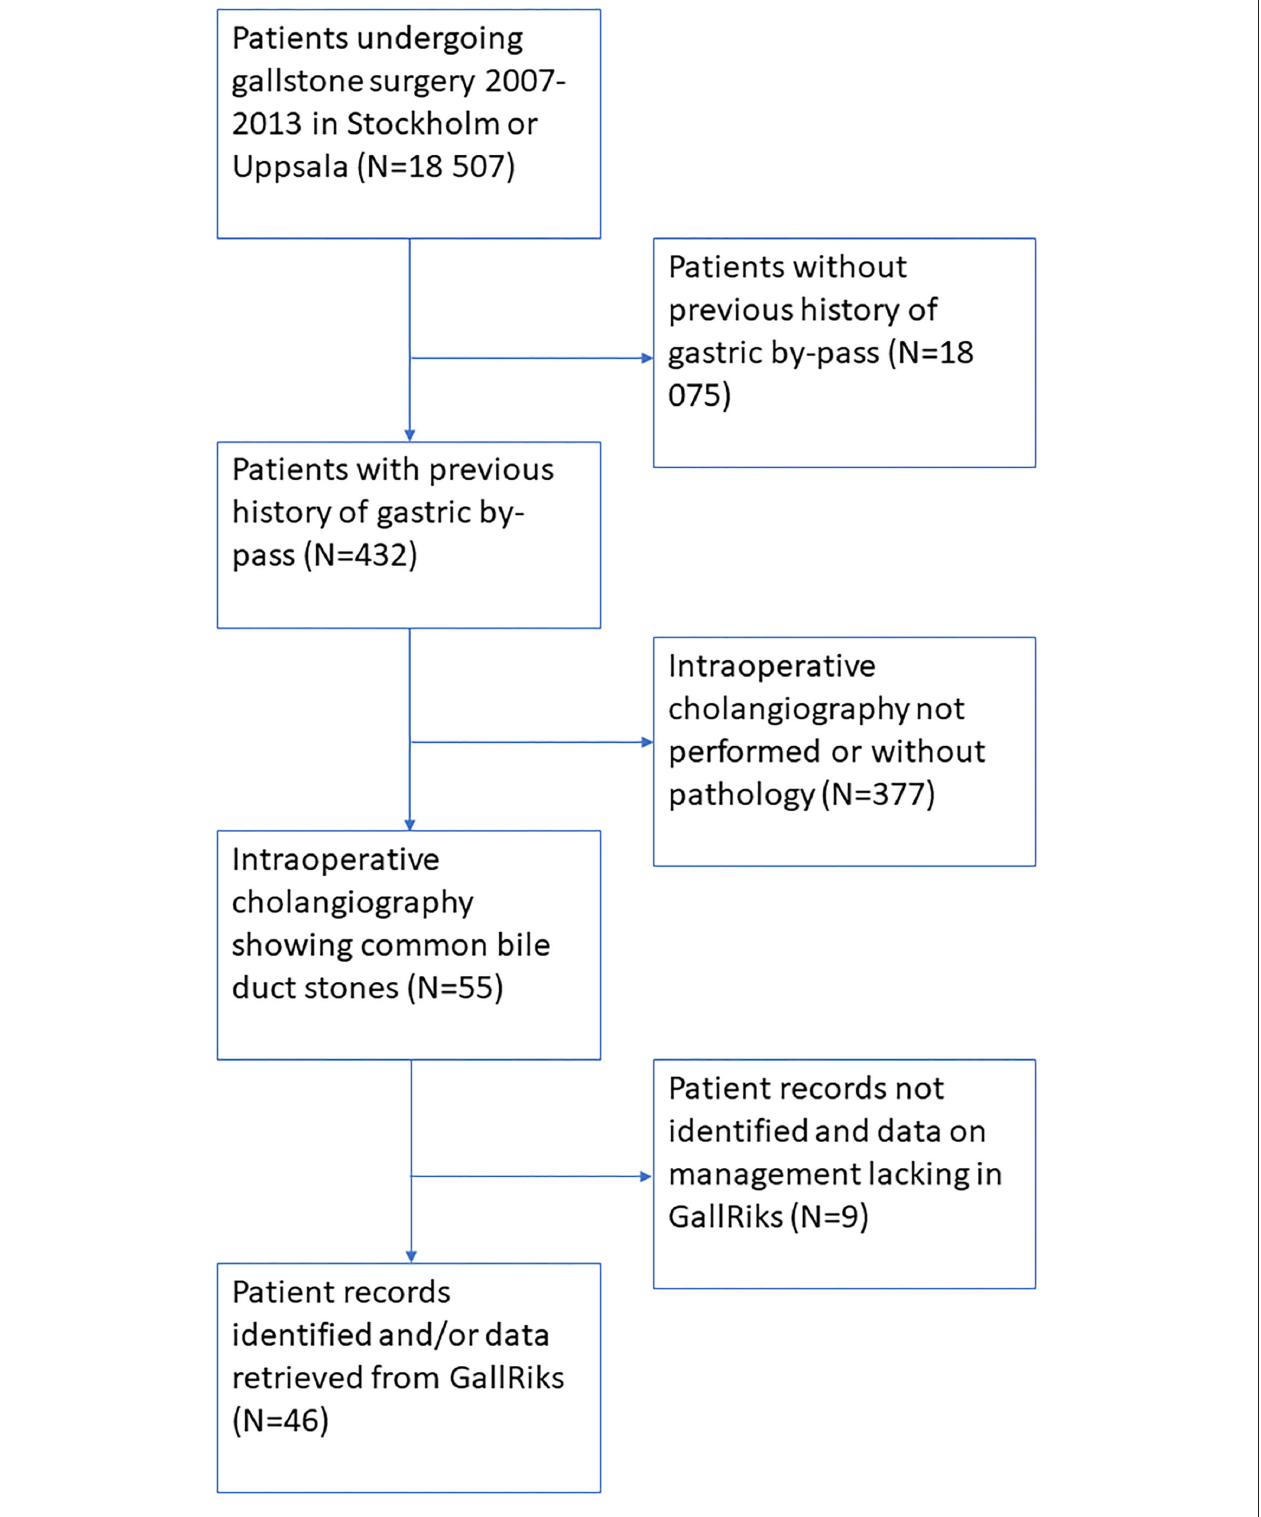
FIGURE 1 | Flow chart.